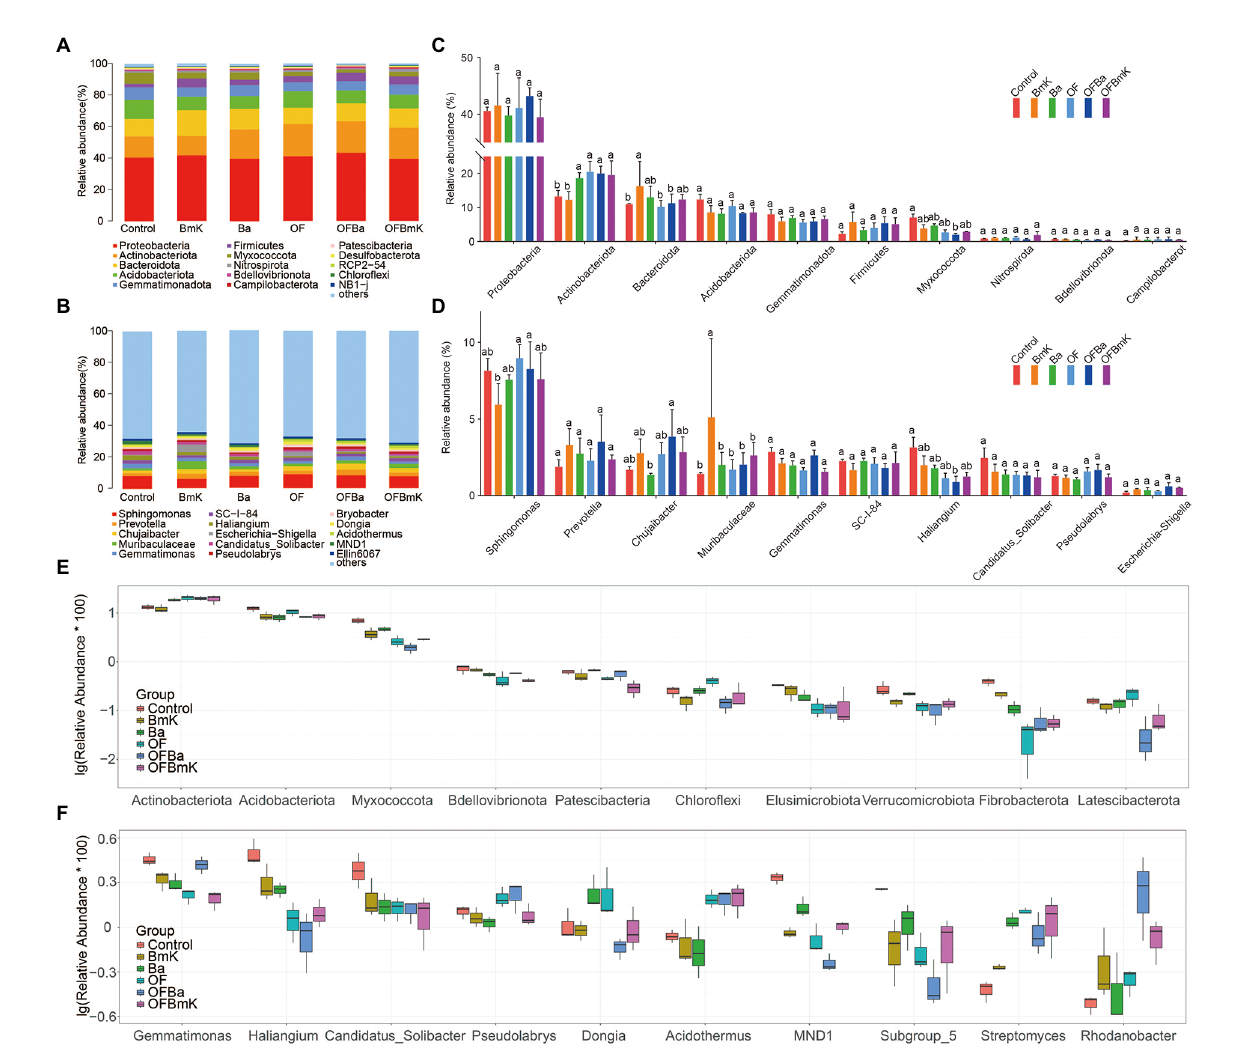
FIGURE 4 Effect of different fertilization treatments on the soil microbial community composition at the phylum and genus levels. Phylum (A) and genus (B) levels of the top 15 most abundant microorganisms. The species belonging to the top 10 most abundant phyla (C) and genera (D) were selected, and the differences between treatment groups were calculated using the one-way ANOVA and Tukey post-hoc test; different letters represent significant differences between the mean values ( p < 0.05, n = 3). Boxplot of differential species at the level of phylum (E) and genus (F) levels; the top 10 diverse species were selected and analyzed by ANOVA to compare the abundance of dominant species within and between treatment